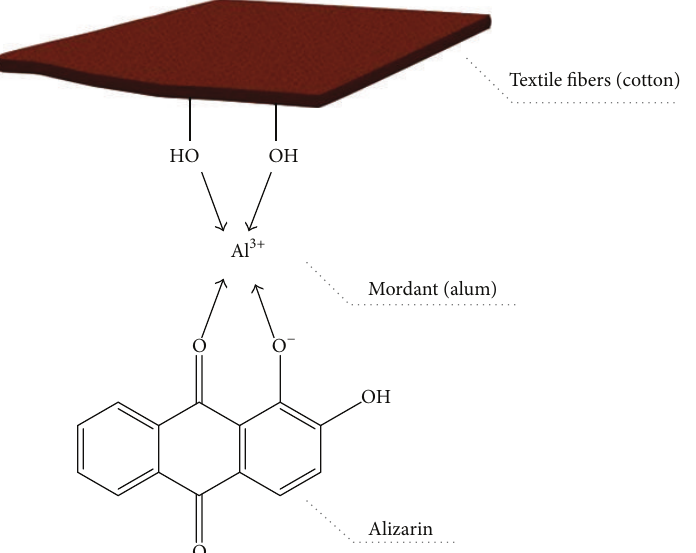
Figure 1: Chemical structure of alizarin anion and the bonding mechanism to the cotton fiber mediated by the presence of the Al 3+ ion from the mordant.